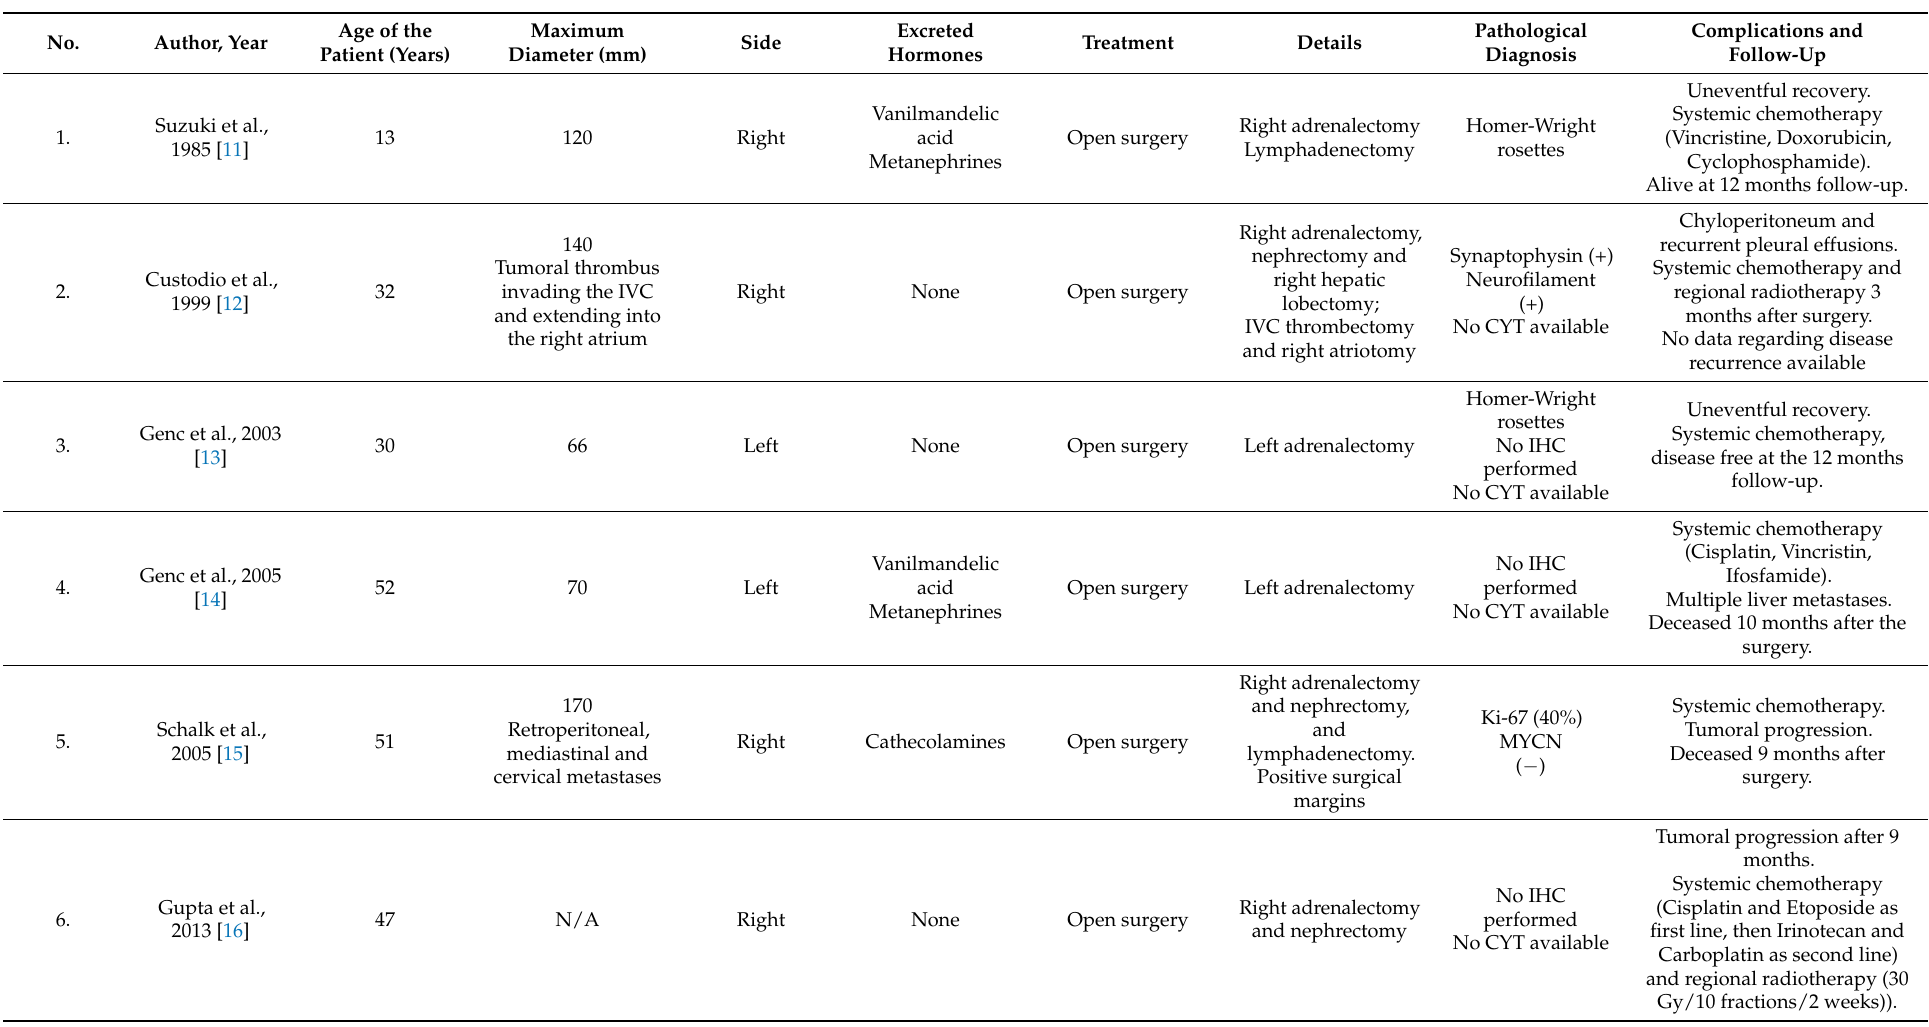
Table 3. Cases of adrenal neuroblastoma in adult patients published to